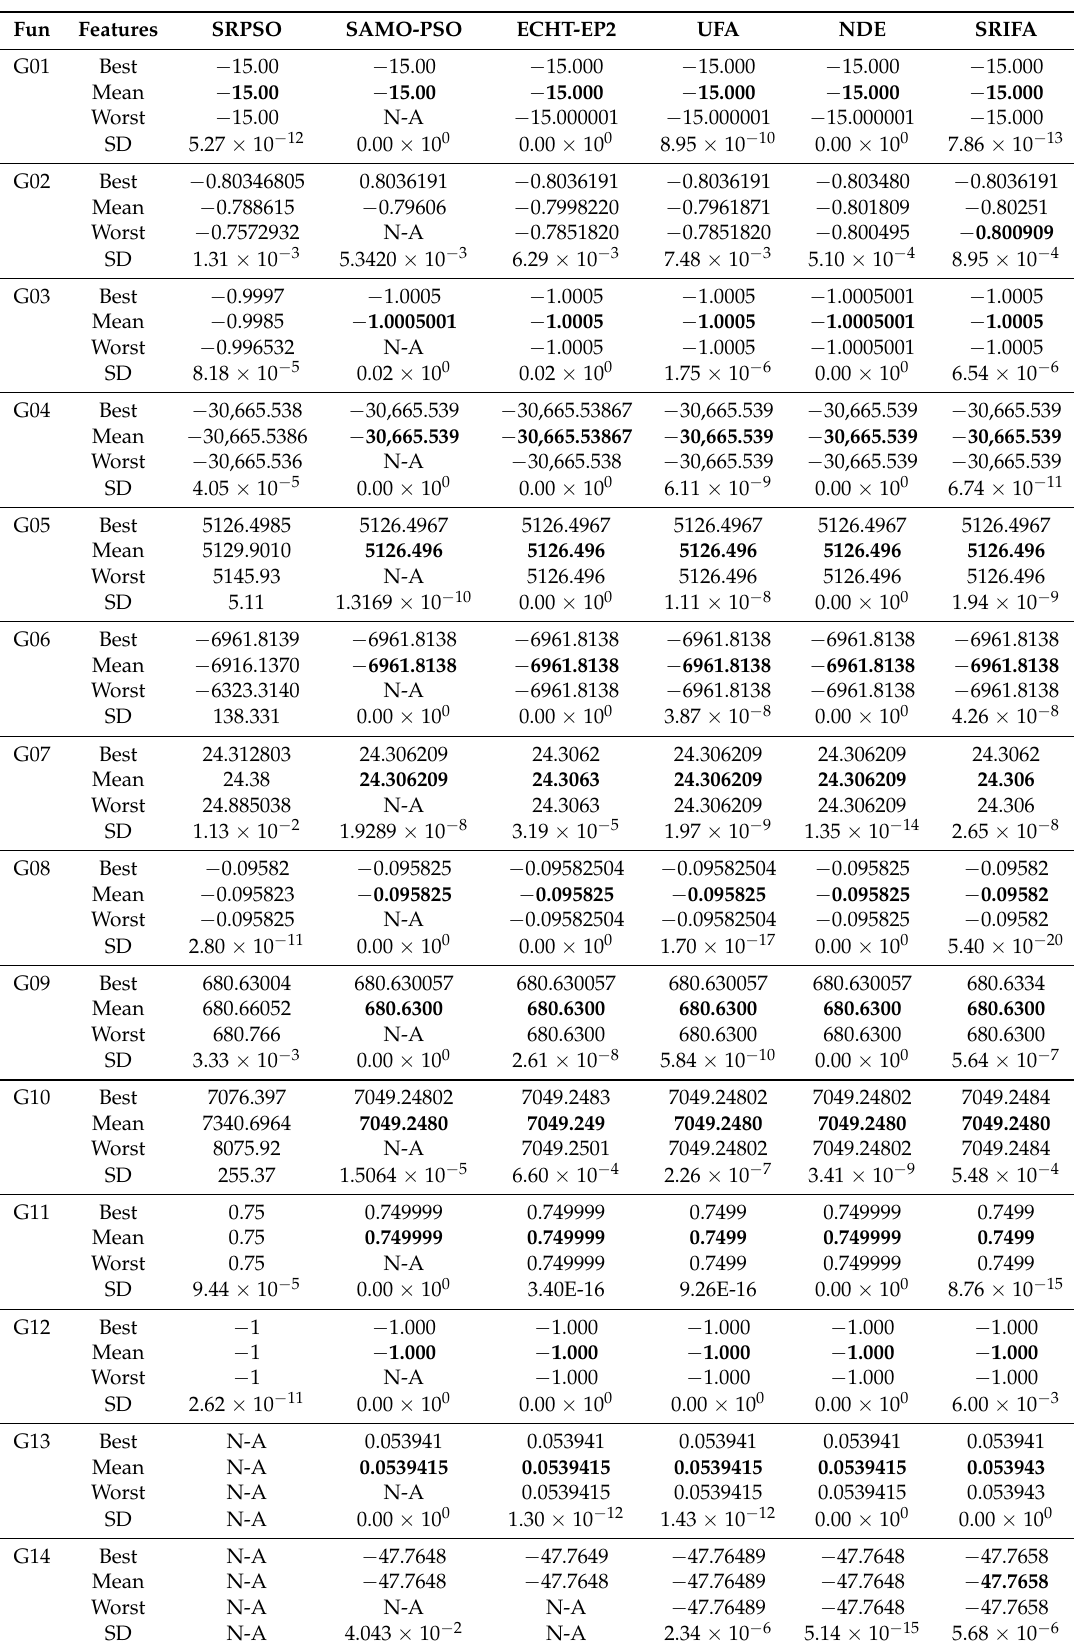
Table 6. Statistical outcomes achieved by SRPSO, SAMO-PSO, ECHT-EP2, UFA, NDE AND